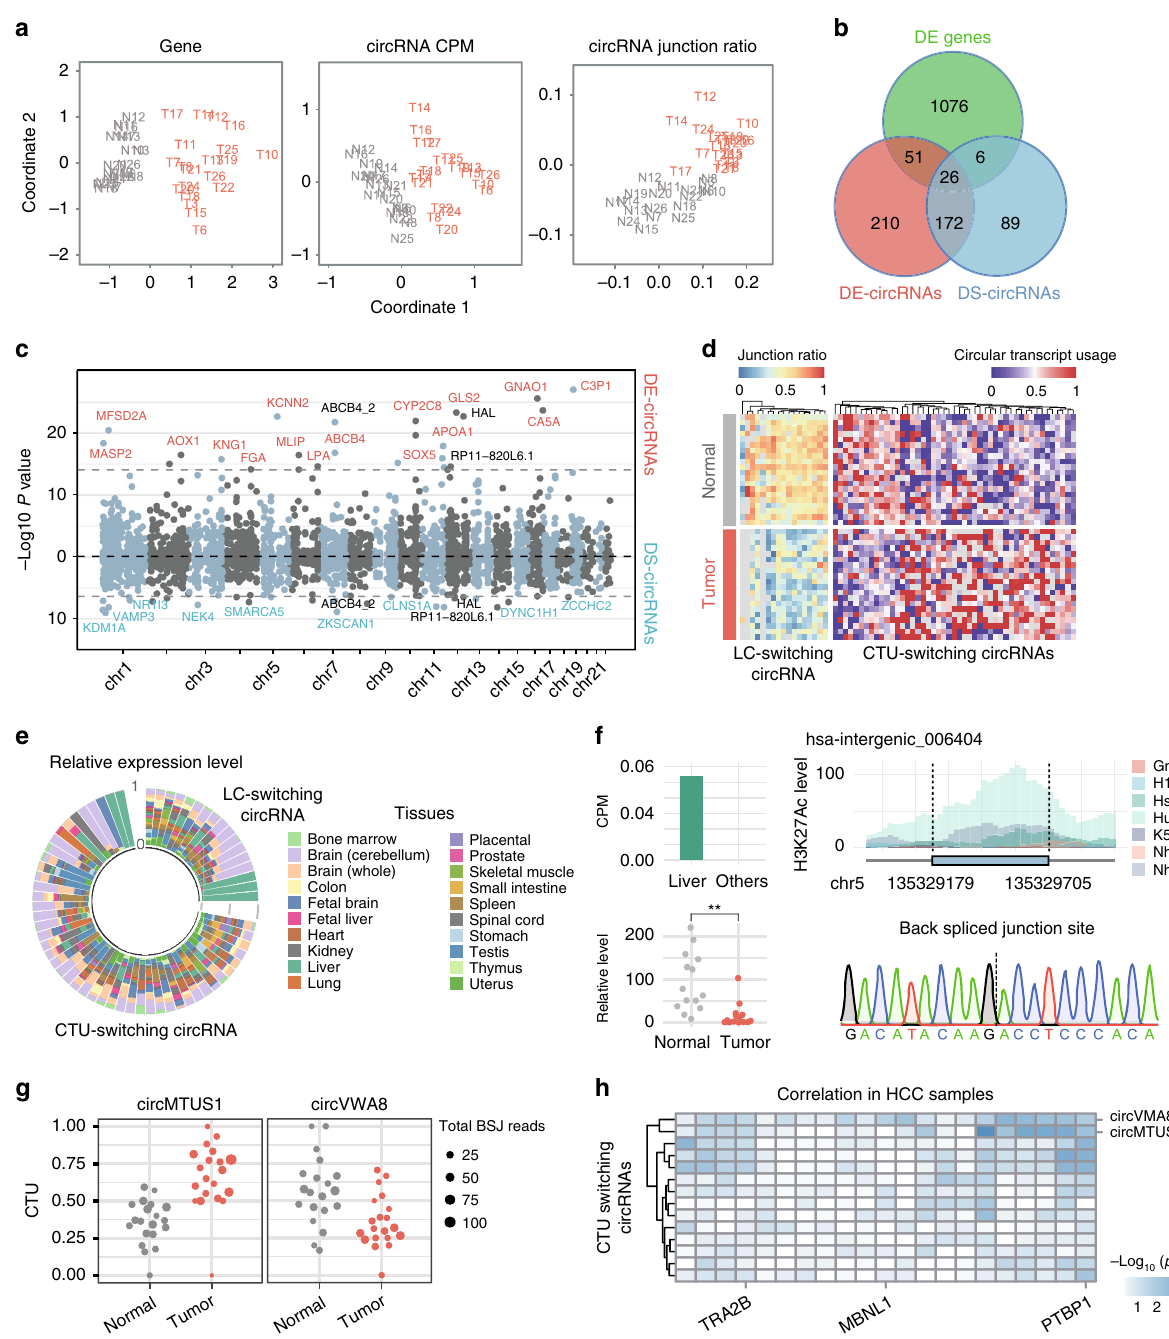
Fig. 6 Differentially expressed circRNAs in hepatocellular carcinoma. a Multi-dimensional analysis using gene expression level, circRNA expression values and junction ratios. Distances between samples are calculated based on log2 fold change. Tumor and normal samples are shown in red and gray, respectively. b Overlap of signi fi cantly changed genes and host genes of DE-circRNAs and DS-circRNAs. c Manhattan plot of p-values from DE- and DS- circRNAs. Horizontal dashed lines indicate top 25 most signi fi cant DE- and DS-circRNAs. DE-speci fi c and DS-speci fi c circRNAs are shown in red and blue, respectively. CircRNAs that are shared by DE and DS groups are shown in black. d Hierarchical clustering of linear-circular (LC) switching and circular transcript usage (CTU) switching circRNAs. The junction ratio and CTU of these circRNA in 20 pairs of HCC samples were plotted, respectively. e Tissue speci fi c expression level of LC-switching and CTU-switching circRNAs. The relative expression level represents the proportion of expression value in speci fi c tissue compared to all 20 tissues. f An instance of LC-switching circRNAs, hsa-intergenic_006404. The bar plot indicates the liver-speci fi c expression pattern of this circRNA. The beeswarm plot shows its expression level in 14 pairs of tumor and normal tissues measured by qPCR. The H3K27Ac marks of upstream and downstream 300 nt region are plotted, indicating the potential biogenesis mechanism of hsa-intergenic_006404 from intergenic region. g Top two CTU-switching circRNAs that are correlated with the most RBPs. h The correlation between RBP expression level and CTU of CTU-switching circRNAs. The color gradient in the heatmap represents the − log10 p value from spearman correlation